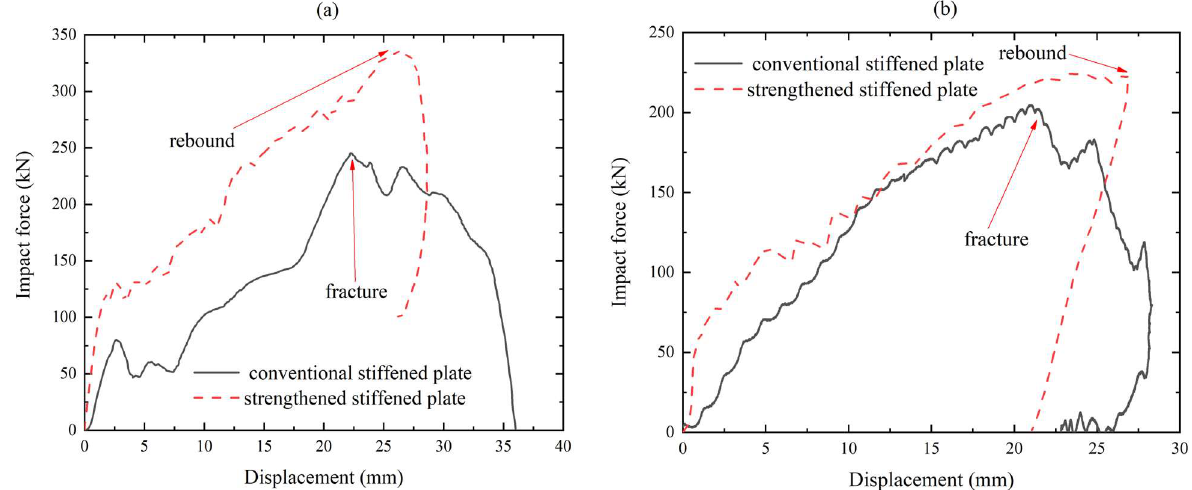
Figure 15. Comparison of impact force–displacement relationships: ( a ) centric impact; ( b ) eccentric impact.